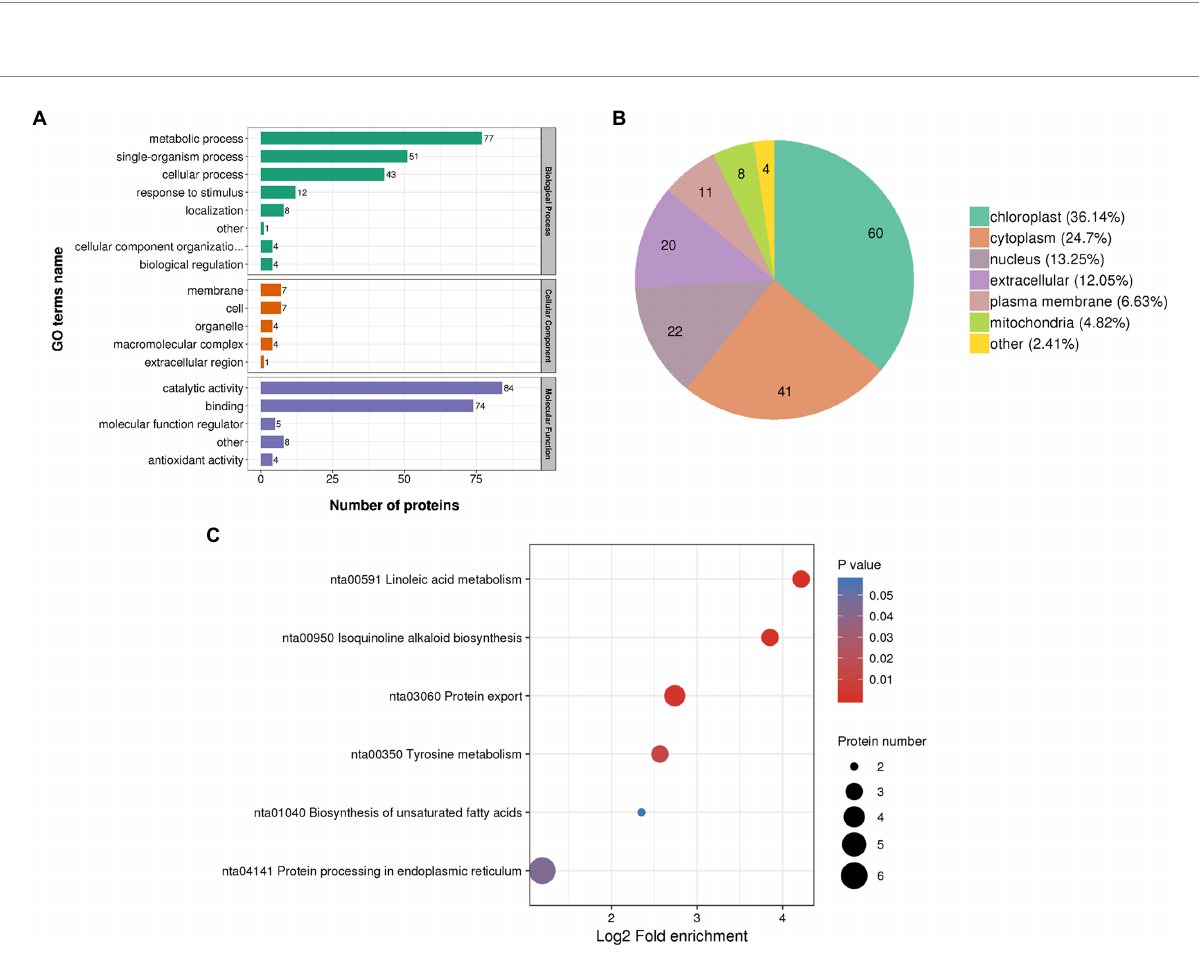
FIGURE 4 Protein expression analysis of transgenic and WT N. benthamiana . (A) GO functional annotation was performed on the screened differentially expressed proteins to illustrate the functional status of the differentially expressed proteins of transgenic and WT N. benthamiana . (B) Subcellular localization of differentially expressed proteins. (C) KEGG pathway analysis was performed on the annotated differentially expressed proteins to understand the biological functions of the differentially expressed proteins.